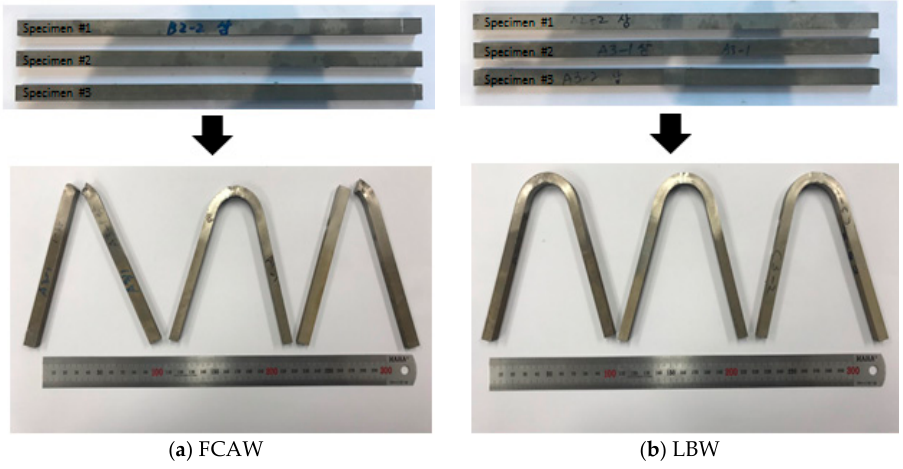
Figure 9. The results of 3-points bending test.